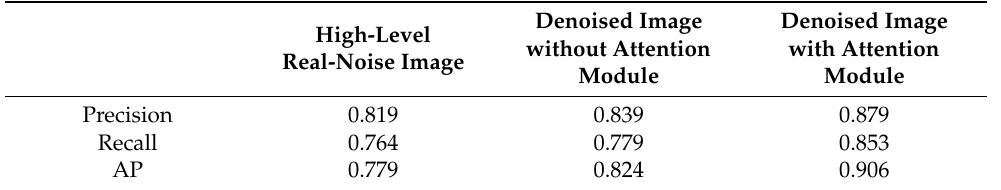
Table 4. Precision, recall, and average precision (AP) on high-level noisy images and the correspond- ing denoised images with and without attention module.